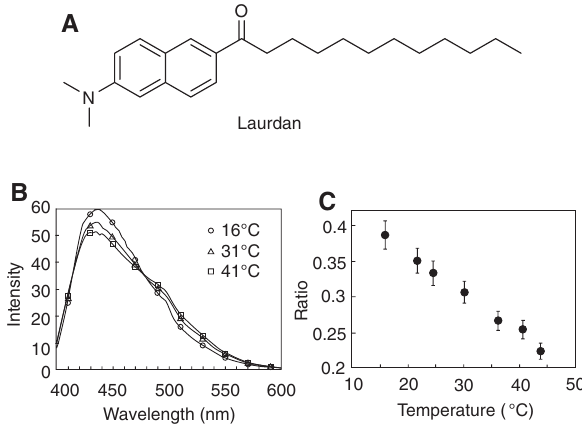
Figure 2: Temperature-sensitive fluorescence of laurdan located in the plasma membrane. (A) Chemical structure of laurdan. (B) Fluorescence spectra of